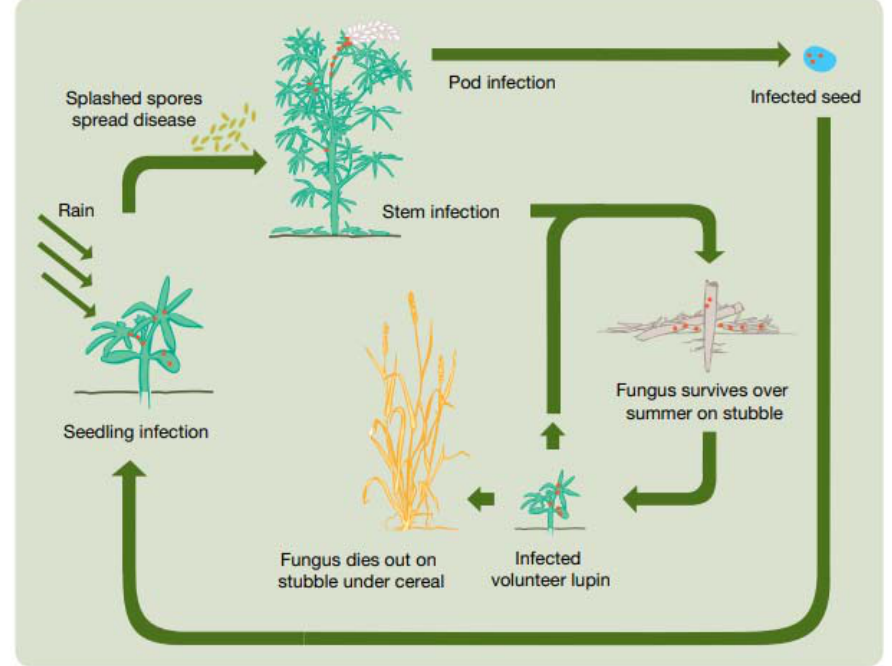
Figure 2. Life cycle of the anthracnose fungus ( Colletotrichum lupini ). Source: M Sweetingham [31].